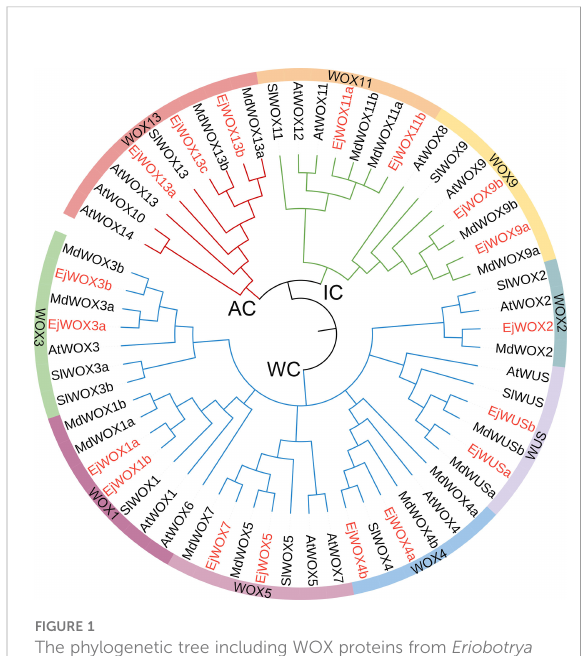
FIGURE 1 The phylogenetic tree including WOX proteins from Eriobotrya japonica, Malus domestica , Solanum lycopersicum , and Arabidopsis thaliana. Nine subgroups of the WOX family are represented by different colors. WC, WUS clade. IC, intermediate clade. AC, ancient clade. The WOX proteins in loquat are marked with